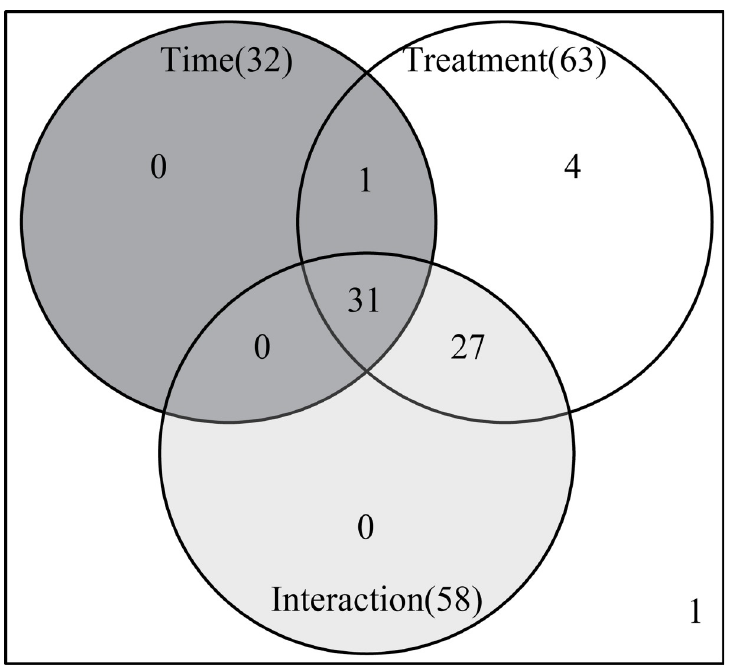
Fig 4. Two-way repeated measures (within subjects) ANOVA of metabolites in U . prolifera fragmentation- induced proliferation during 12–120 h. Pink, purple, and green circles respect time, treatment, and their interaction, respectively; the figures in the circles represent the kinds of metabolites that responded to the element. The following parameters were chosen: ANOVA type, “Type |”; Consider interactions, “Yes”; Adjusted p-value cutoff, 0.05; Multiple testing correction, false discovery